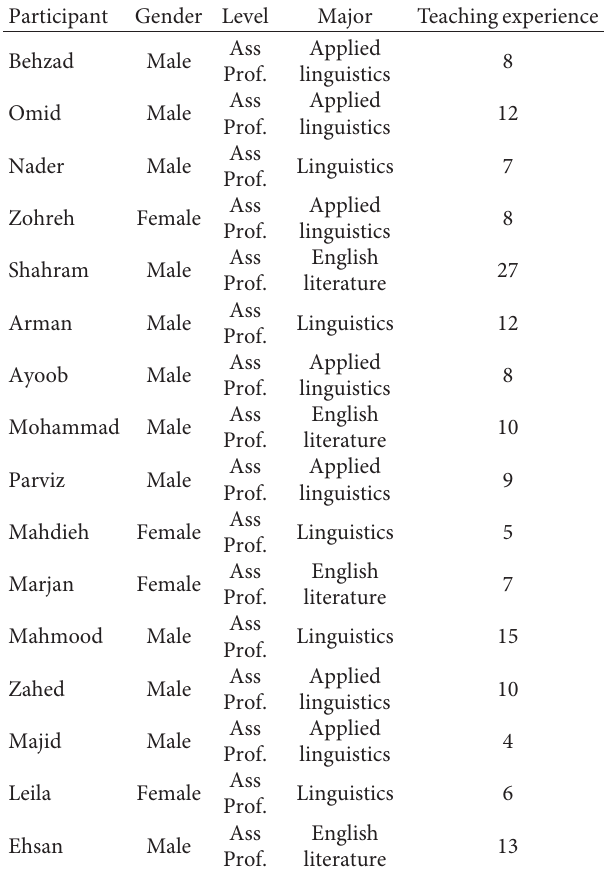
Table 1: Demographic information of the